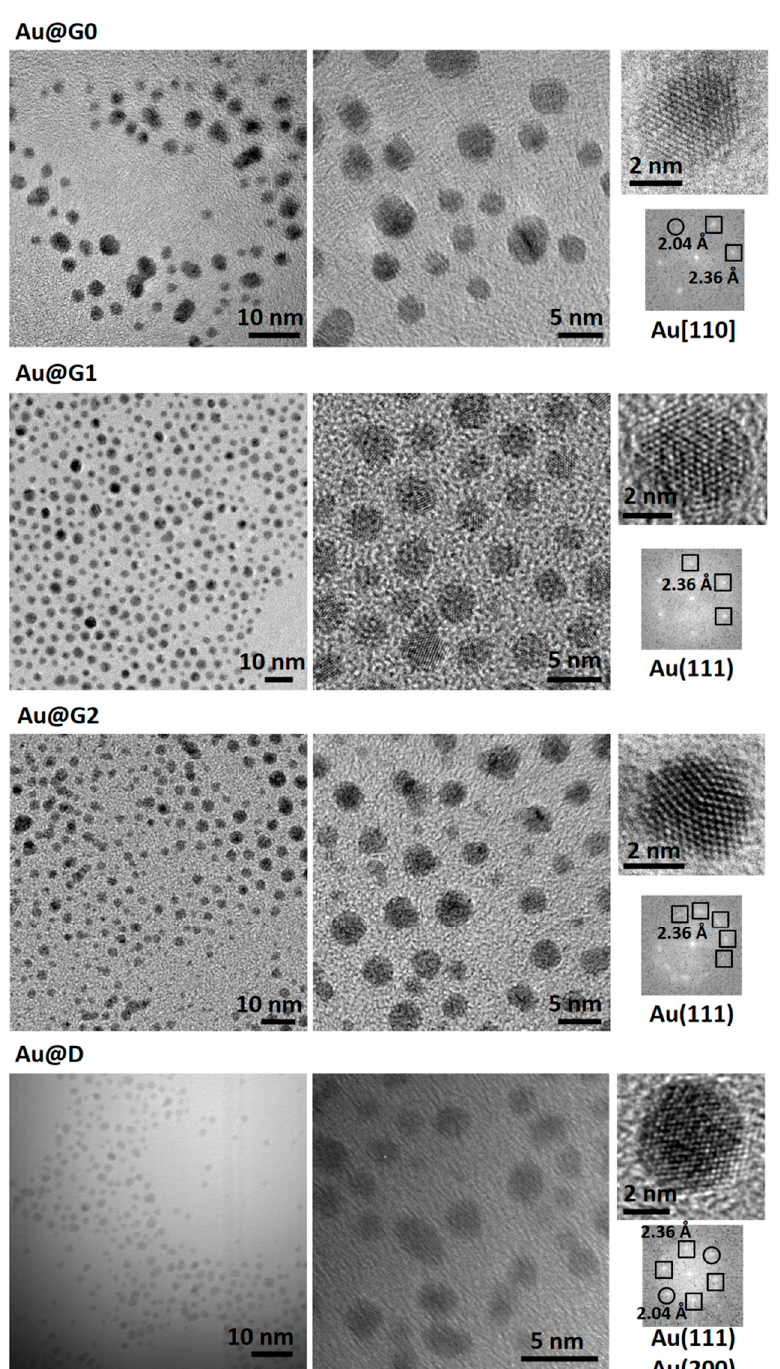
Figure 1. TEM images of the unsupported ligand-protected core–shell Au nanoparticles (NPs) acquired at different magnifications. Table 1. Nomenclature of the gold nanoparticles .